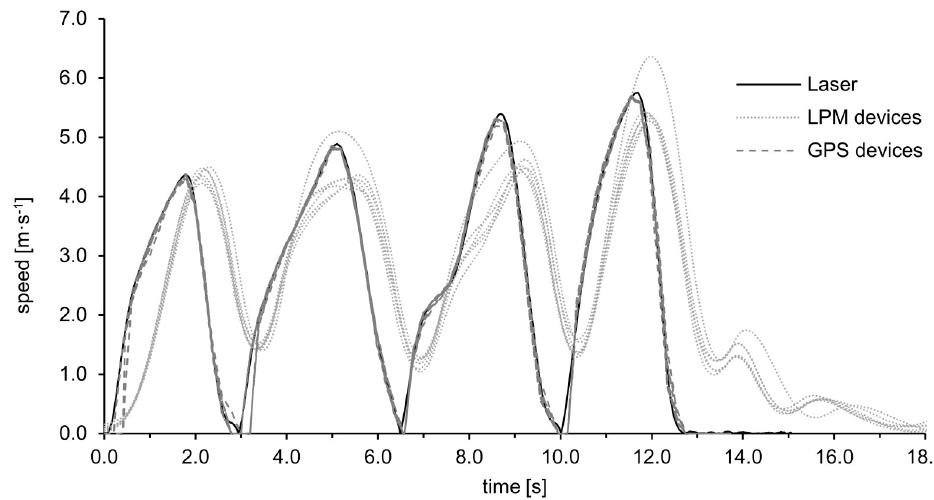
Fig 3. Speed curve of the laser signal, 6 GPS and 6 LPM signals during repetitive high-accelerated shuttle runs 4 x 5m (RA-5m).